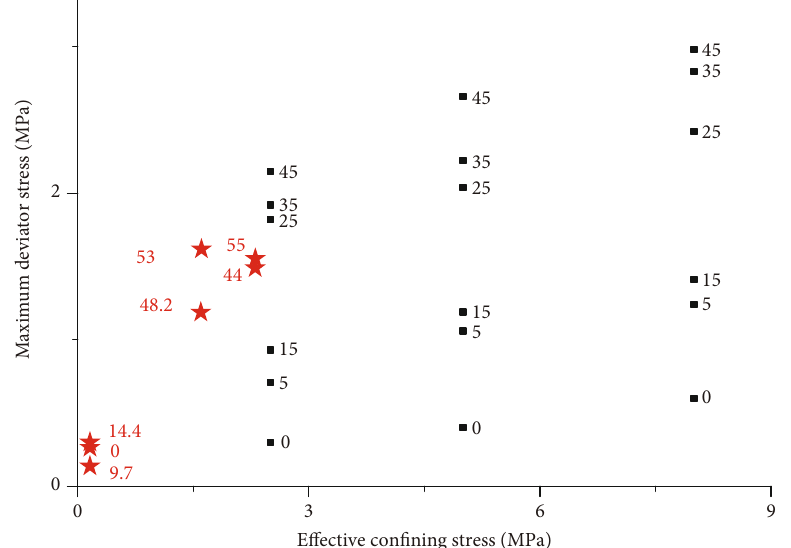
Figure 8: Relationship between the e ff ective con fi ning stress and the peak deviatoric stress. Red star: this study. Black box: previous study [17]. The numbers are the gas hydrate saturation within the